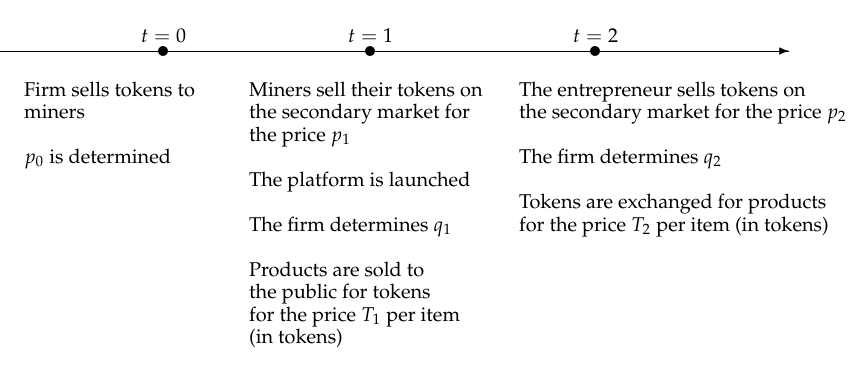
Figure 1. The sequence of events for utility